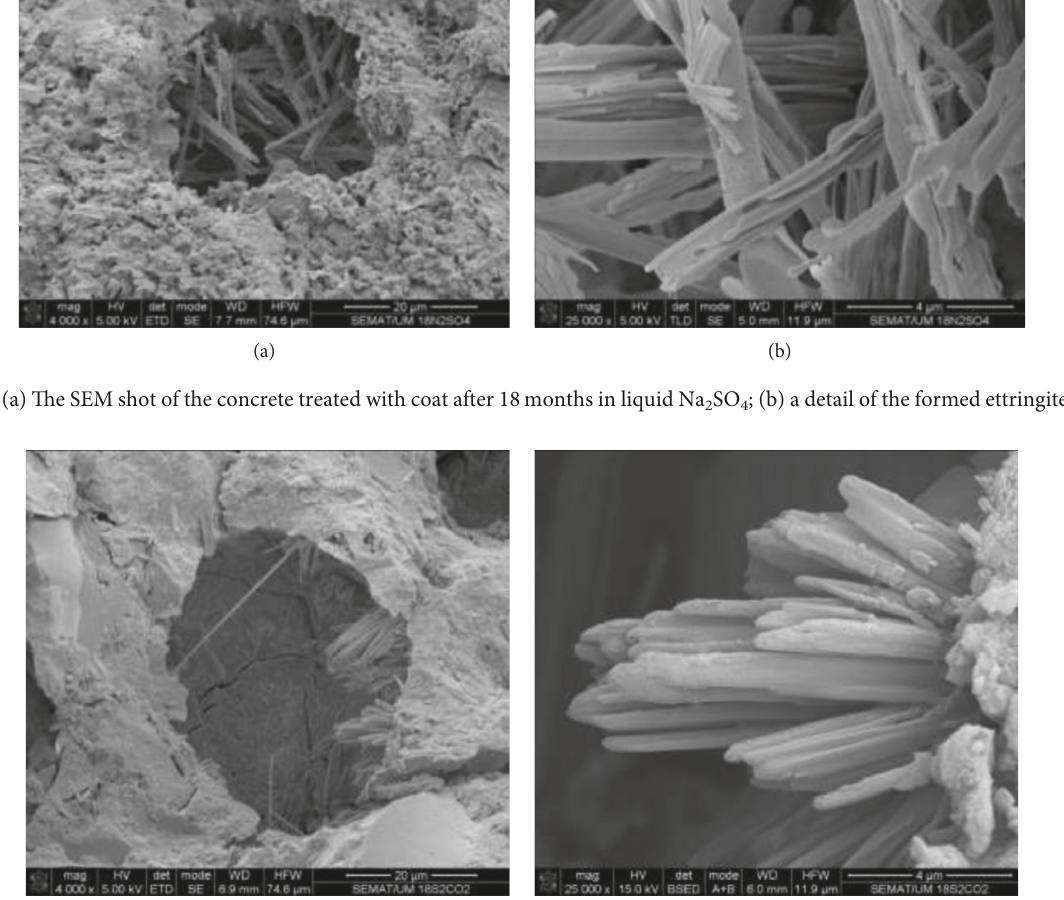
Figure 12: (a) The SEM shot of concrete treated with screed after 18months in gaseous CO pseudomorphoses of aragonite crystals.